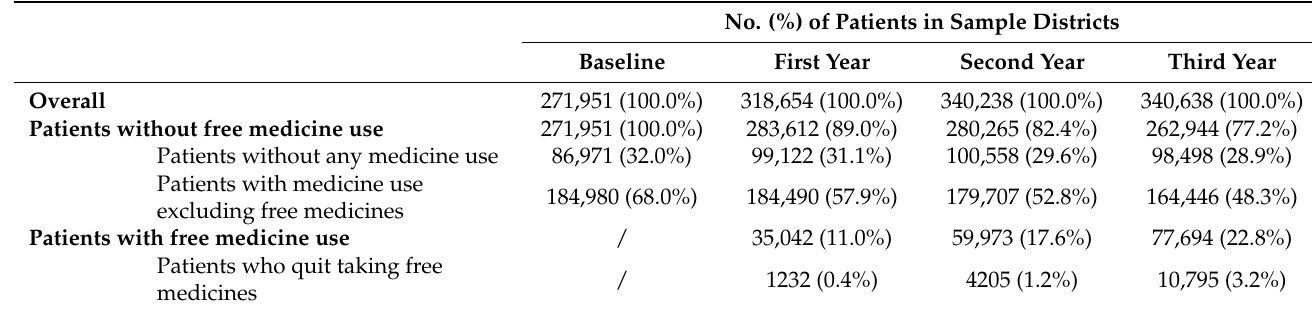
Table 1. Number and proportion of patients with and without free medicine use in